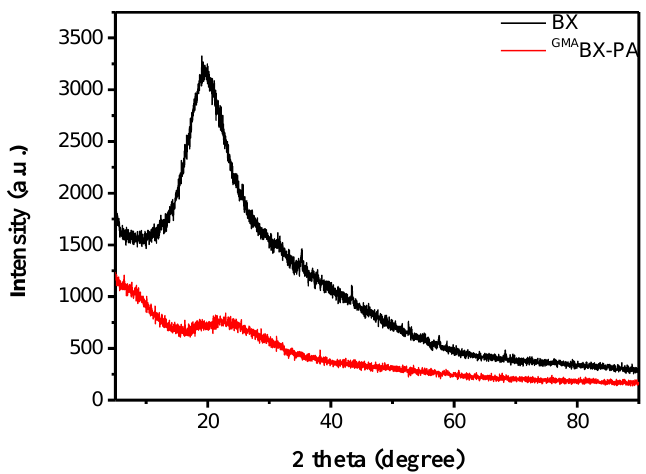
Figure 6. XRD pattern of BX and GMA BX-PA.